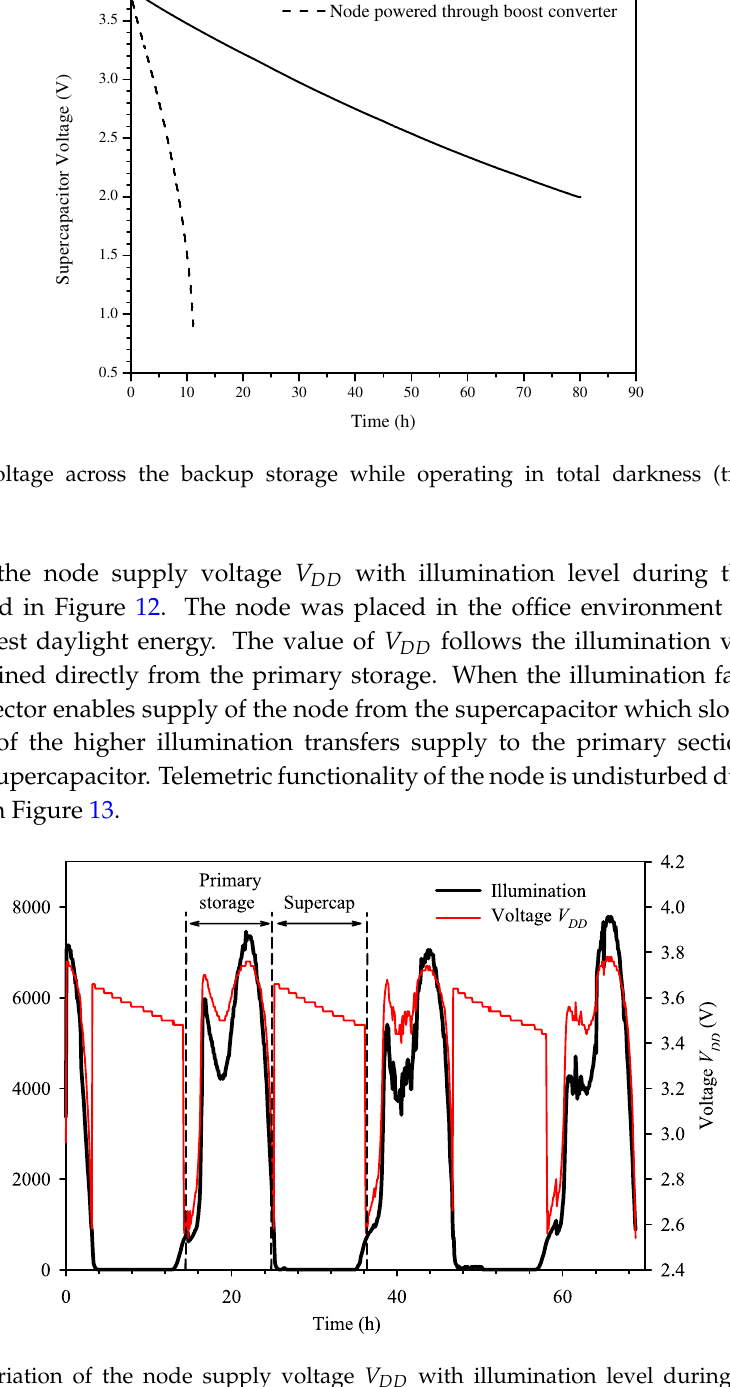
Figure 12. Variation of the node supply voltage V DD with illumination level during the period 28 August 2015–31 August